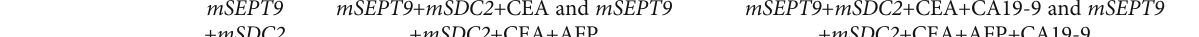
Table 3: Performance of combining both DNA methylation biomarkers and tumor markers for detecting di ff erent disease states.